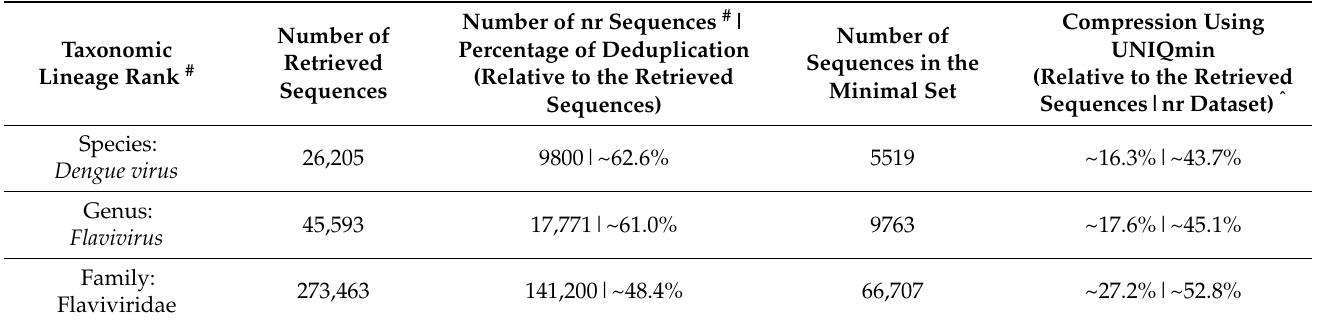
Table 1. A summary of compression using UNIQmin across the viral lineages ranks, namely species, genus, and